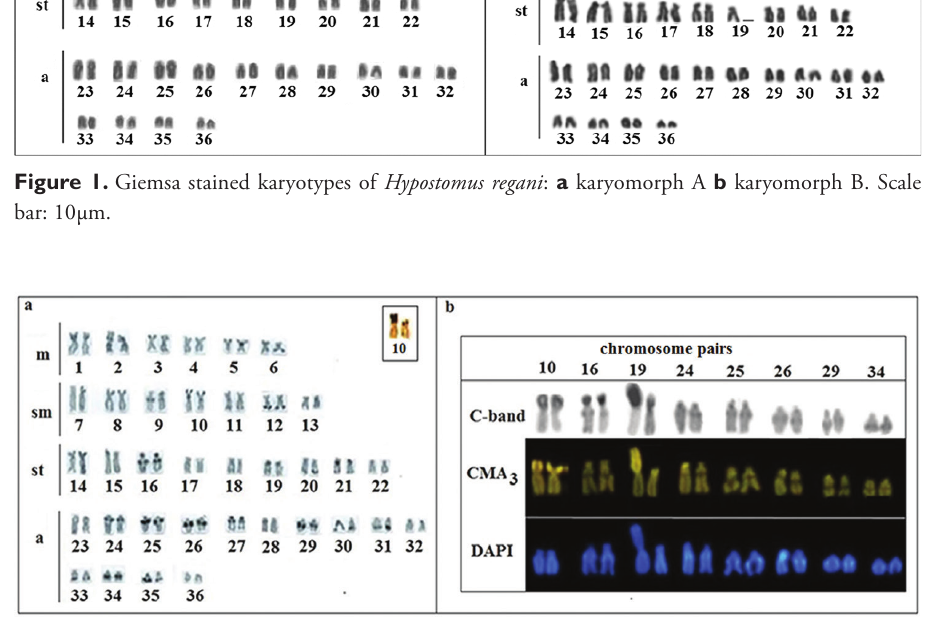
Figure 2. Karyotype of Hypostomus regani (karyomorph A) after: a C-banding and the NOR-bearing chromosome pair (in box) b Some pairs of chromosomes of the karyomorph B showing corresponding bands of C-banding, CMA and DAPI stained. Scale bar: 3